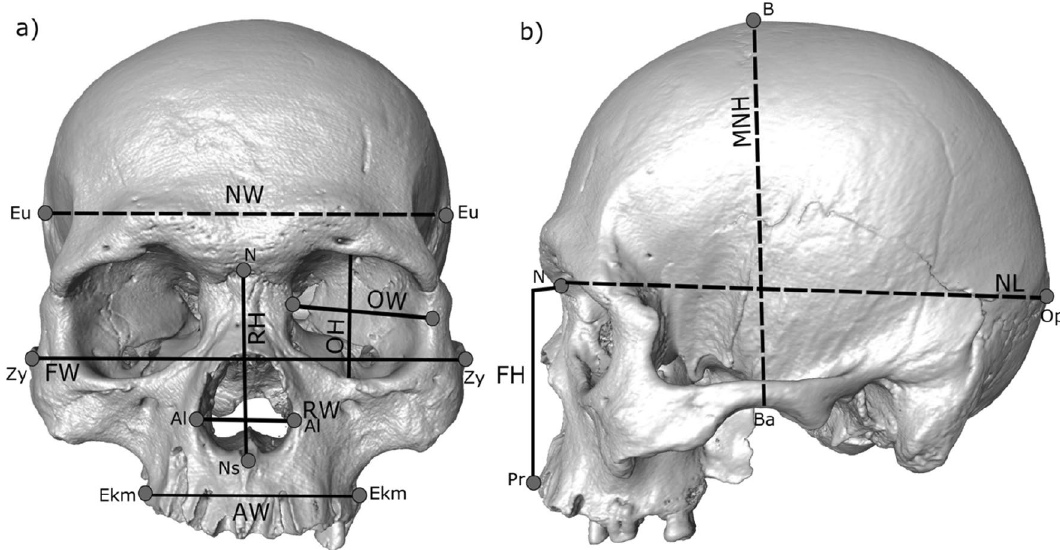
Figure 6. Craniofacial measurements used for this study (see Table 3) in frontal ( a ) and lateral view ( b ). Solid lines indicate facial skeleton measurements, and dashed lines, neurocranial measurements. References: NW = Neurocranial length (Eu: Eurion—Eu: Eurion); FW = Facial width (Zy: Zygion—Zy: Zygion); AW = Alveolar width (Ekm: Ectomolare—Ekm: Ectomolare); RW = Respiratory width (Al: Alare-Al: Alare); RH = Respiratory height (N: Nasion—Ns: Subespinale); OW = Optic width (D: Dacryon—Ec: Ectoconquion); OH = Optic height (maximum height from the upper to the lower orbital borders perpendicular to the horizontal axis of the orbit); NL = Neurocranial length (N: Nasion—Op: Opistochranion); MNH = Midneural height (Ba: Basion—B: Brema); FH = Facial height (N: Nasion—Pr: Prosthion). Figure generated with